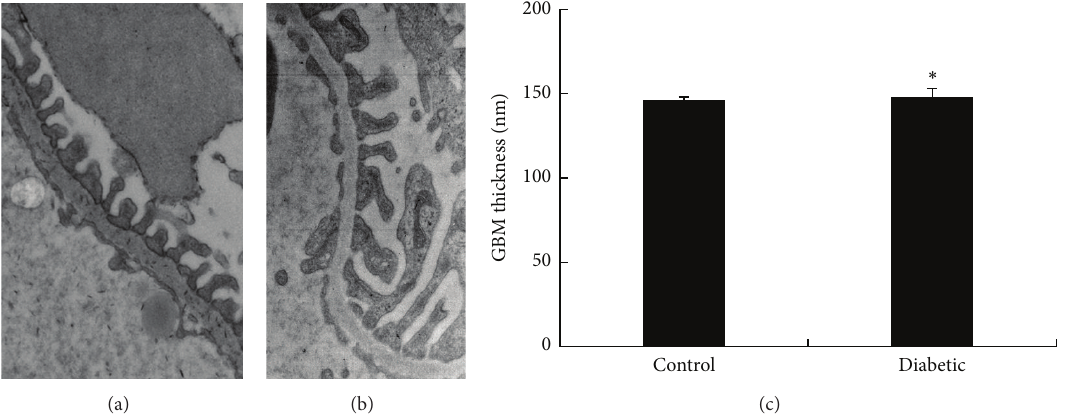
Figure 6: Morphological changes in the GBM of the glomerulus. (a) Control rats, (b) diabetic rats, and (c) thickness of the GBM ( ∗ 𝑃 > 0.05 ).